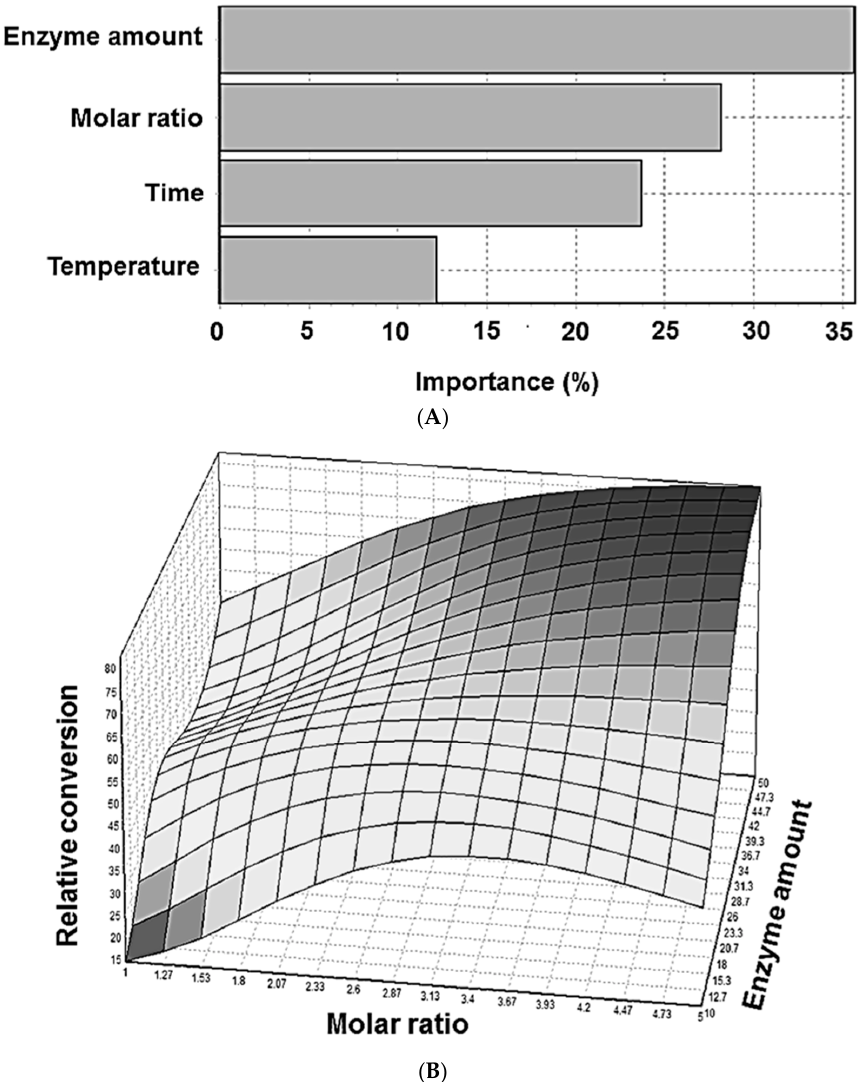
Figure 7. Influence of experimental variables on the lipase-catalyzed synthesis of retinyl laurate. ( A ) Importance of experimental variables in retinyl laurate synthesis. The analysis was done by Neural Power software (CPC-X Software, USA); and ( B ) the response surface plot of the ANN showing the relationships between the relative conversion of retinyl laurate and reaction parameters (molar ratio and enzyme amount).